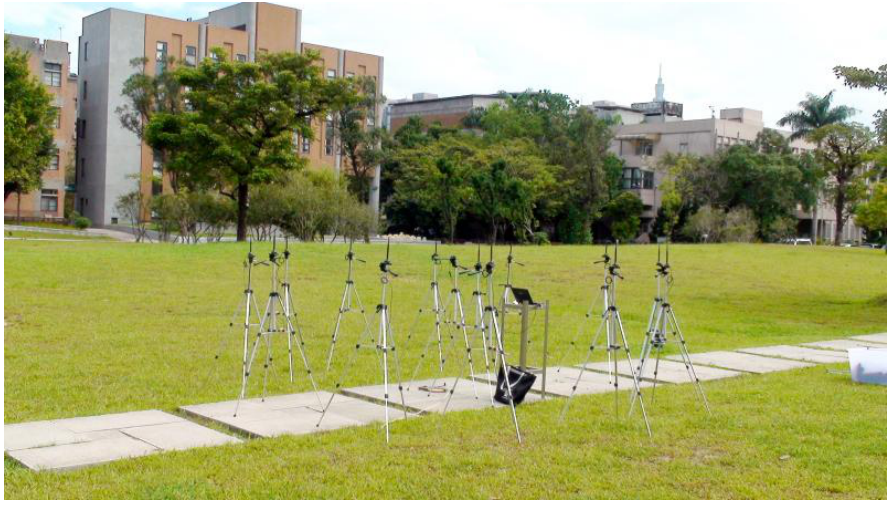
Figure 11. Testing environment of the experiment located on the campus of the National Taiwan